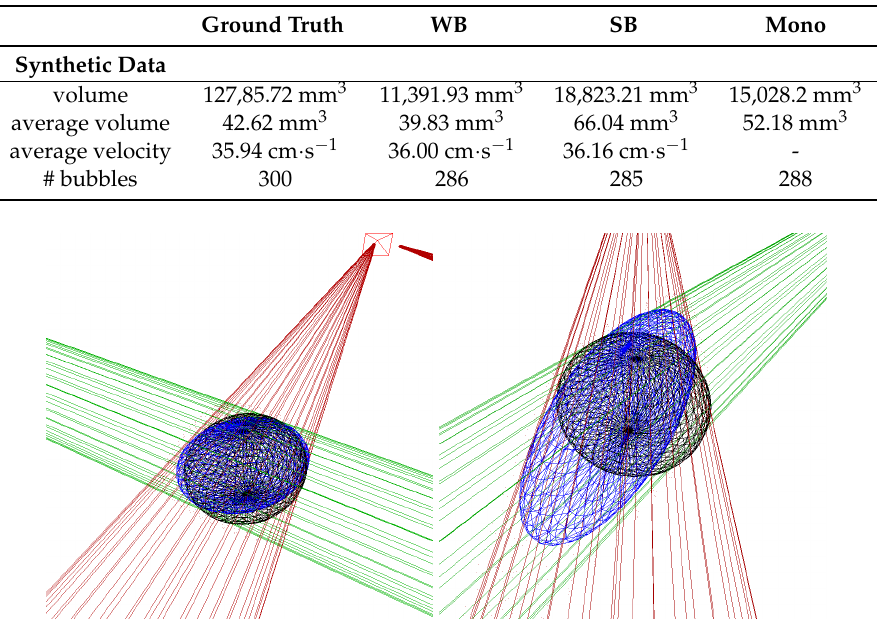
Table 1. Results on synthetic data. The first column shows the ground truth results. WB stands for wide-baseline scenario, SB for small-baseline scenario and Mono shows an estimate for using one camera only based on a pixel-to-mm conversion ratio.